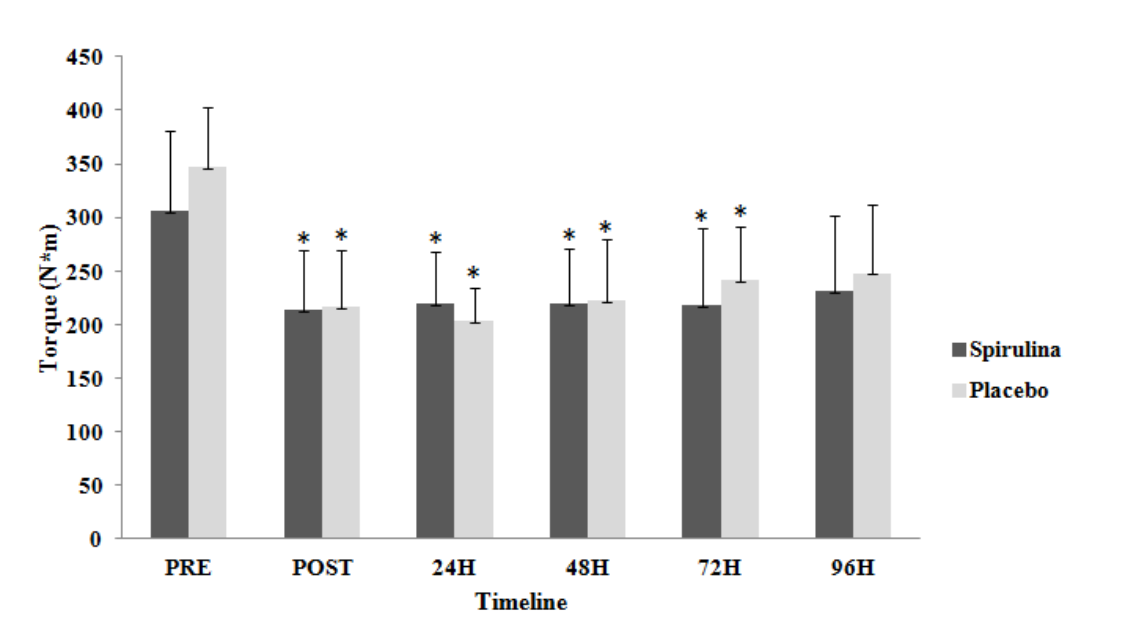
Figure 3. Change of eccentric peak torque for left limb in response to eccentric protocol. PRE, Baseline measurement; H, Hours; * Significant difference with PRE.